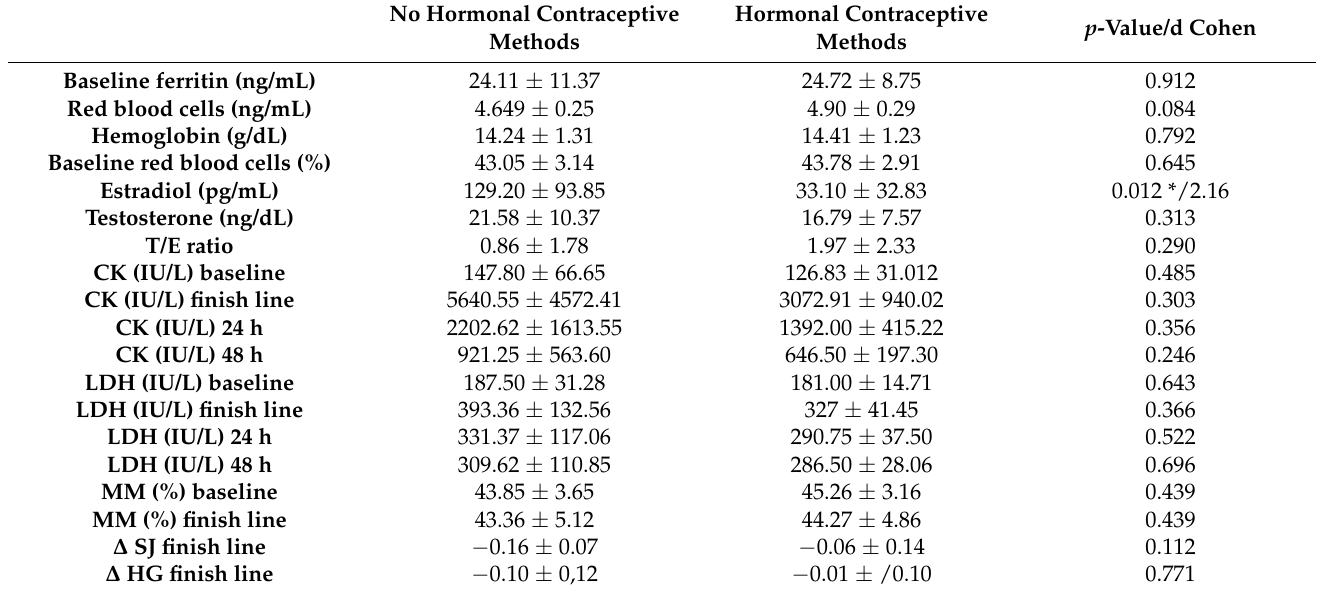
Table 3. Relation between contraceptive groups and study variables.